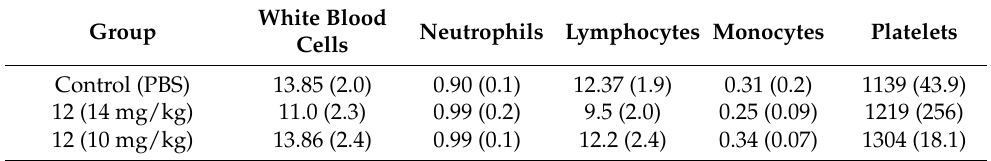
Table 2. Haematology data for for Sprague–Dawley rats on day 8 following total dose intravenous administrations of 12 at 14 mg/kg (2 × 7 daily administrations) and 10 mg/kg versus control ( n = 3). White Blood Neutrophils Lymphocytes Monocytes Platelets Group Cells Control (PBS) 13.85